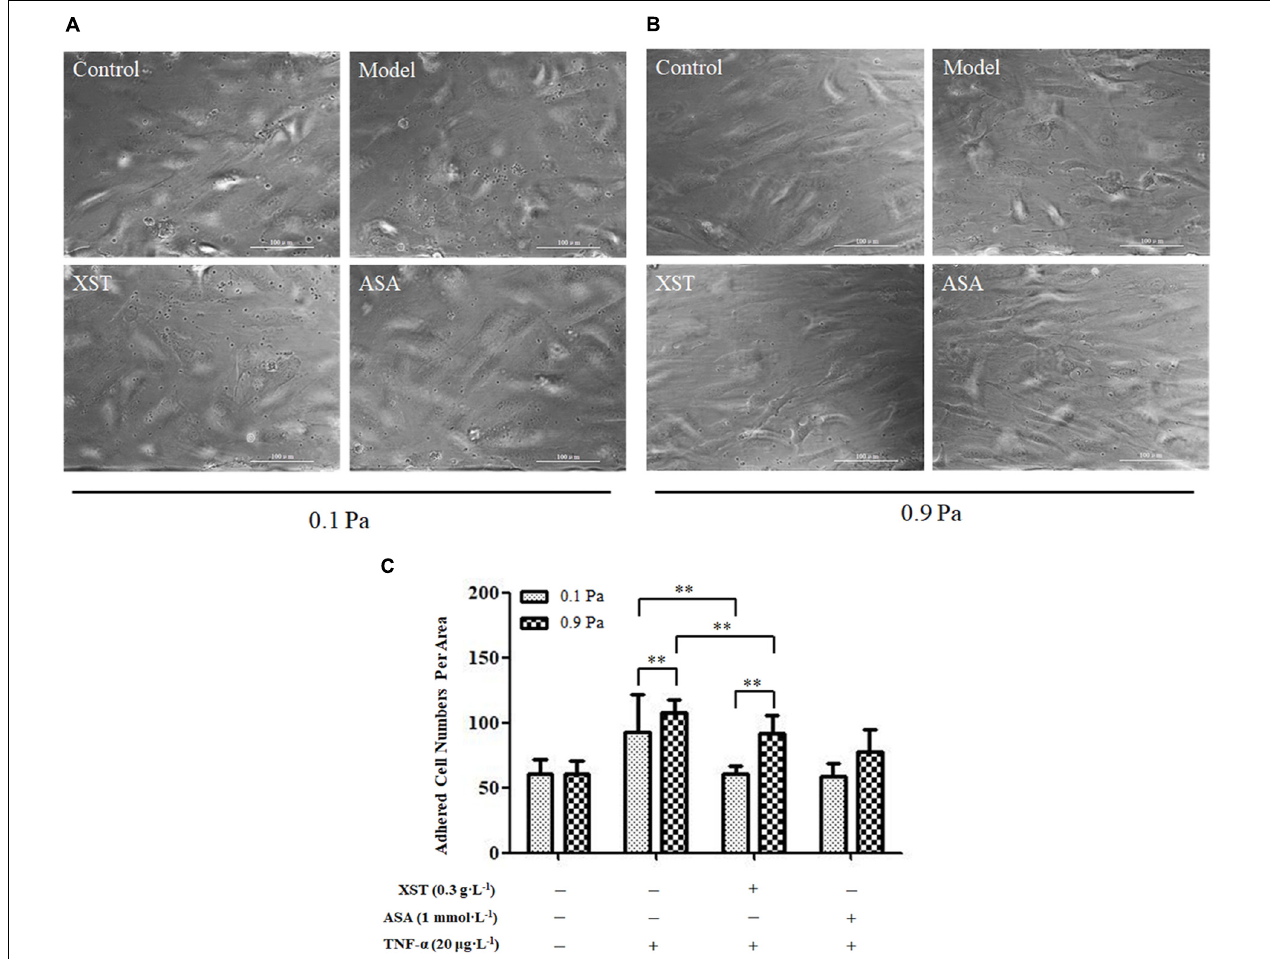
FIGURE 3 | Comparisons of platelets adhesion between groups. (A) under 0.1 Pa flow condition, and (B) under 0.9 Pa flow condition (magnification × 200). (C) Histogram demonstrating the platelets adherence on activated HUVECs under different flow conditions. The data was presented as means ± SD, n = 9; data was analyzed by two-way ANOVA as described in Methods; analysis of simple effects. ∗∗ P < 0.001.